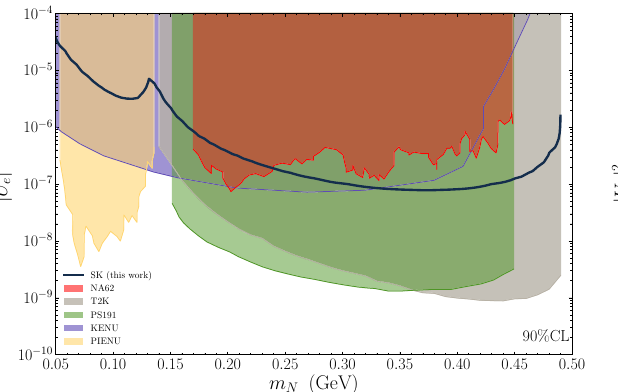
vanishing U α at a time. Our results are shown in Fig. 3